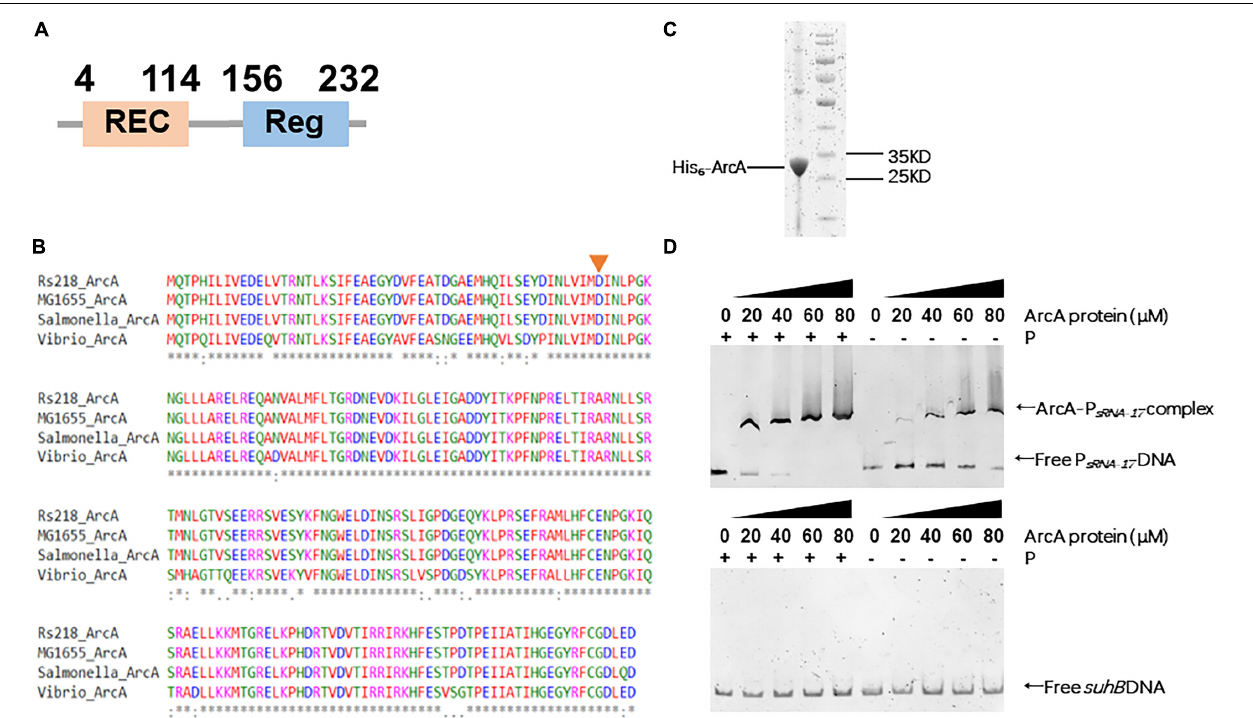
FIGURE 4 | Phosphorylated ArcA strongly binds the sRNA-17 promoter from Escherichia coli K1 Rs218. (A) Domain organization of ArcA protein from E. coli K1 Rs218. (B) MAFFT-based protein sequence alignment of ArcA proteins from E. coli K1 Rs218, E. coli K12 MG1655, Salmonella enterica subsp. enterica serovar Typhimurium American Type Culture Collection (ATCC) 14028, and Vibrio cholerae O1 biovar EI Tor str. N16961. The aspartic acid residue 54 (indicated by an orange arrow), which receives phosphorelay is conserved in the four ArcA proteins. An * indicates that amino acid positions have a single, fully conserved residue. A: indicates amino acid positions are conserved with groups of strongly similar properties. (C) Sodium dodecyl sulfate–polyacrylamide gel electrophoresis (SDS-PAGE) of purified ArcA-His 6 by HiTrap Ni 2 + -chelating column. (D) Electrophoretic mobility shift assays (EMSAs) of sRNA-17 promoter DNA fragment with purified ArcA-His 6 protein (0, 20, 40, 60, and 80 µ M) with or without the acetyl phosphate (top panel) . EMSA of suhB gene fragment with purified ArcA-His 6 protein (0, 20, 40, 60, and 80 µ M) with or without the acetyl phosphate (bottom panel)